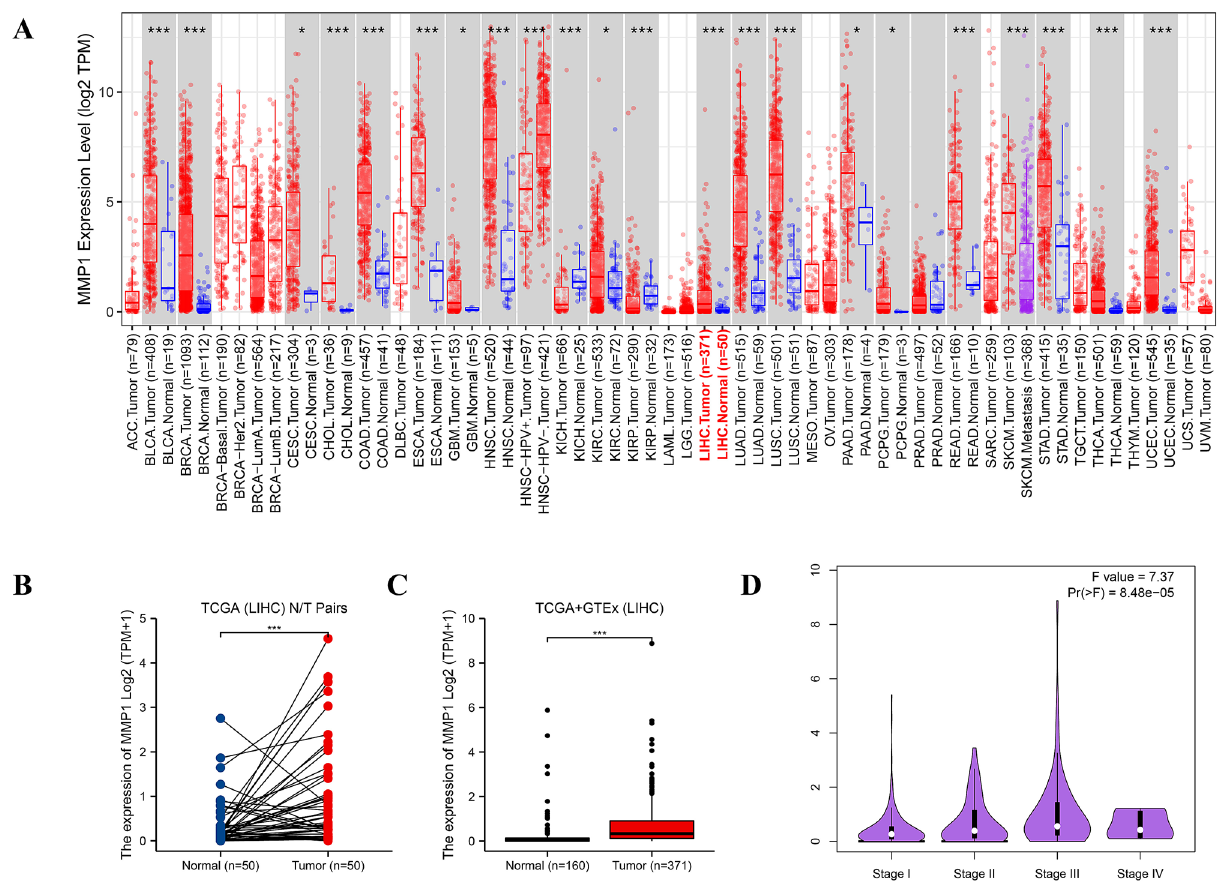
Figure 3. MMP1 expression levels in different tumors, tissues and pathological stages. ( A ) Analysis of MMP1 expression level in different tumors or their subtypes and corresponding normal tissues via TIMER2.0. ( B ) Paired comparison of MMP1 expression level in LIHC. ( C ) Unpaired comparison of MMP1 expression level in LIHC by including the relevant normal tissues of the GTEx database as controls. ( D ) Analysis of MMP1 expression in different pathological stages of LIHC. LIHC, liver hepatocellular carcinoma. * P < 0.05, ** P < 0.01, *** P < P = 0.011, n = 373. Figure 6B). We subsequently conducted subgroup survival analysis for an in-depth evalu- ation of the correlation between MMP1 expression and various of clinicopathological factors (Table 3). Ele- vated MMP1 expression was associated with a worse OS in T1 stage (HR = 2.14, 95%CI = 1.17–3.19, P = 0.013), M0 stage (HR = 1.62, 95%CI = 1.05–2.51, P = 0.029), tumor-bearing (HR = 1.57, 95%CI = 1.00–2.46, P = 0.049), pathologic stage I (HR = 2.21, 95%CI = 1.17–4.17, P = 0.014), males (HR = 2.23, 95%CI = 1.41–3.52, P = 0.001), age ≤ 60 (HR = 2.07, 95%CI = 1.21–3.57, P = 0.008) or age > 60 (HR = 1.61, 95%CI = 1.01–2.56, P = 0.046), BMI ≤ 25